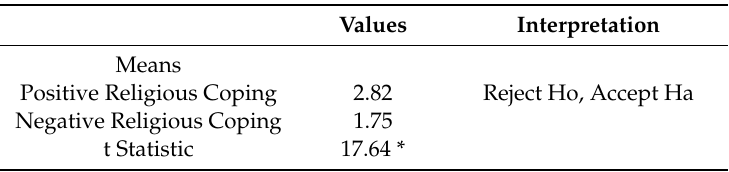
Table 5. Paired T-test